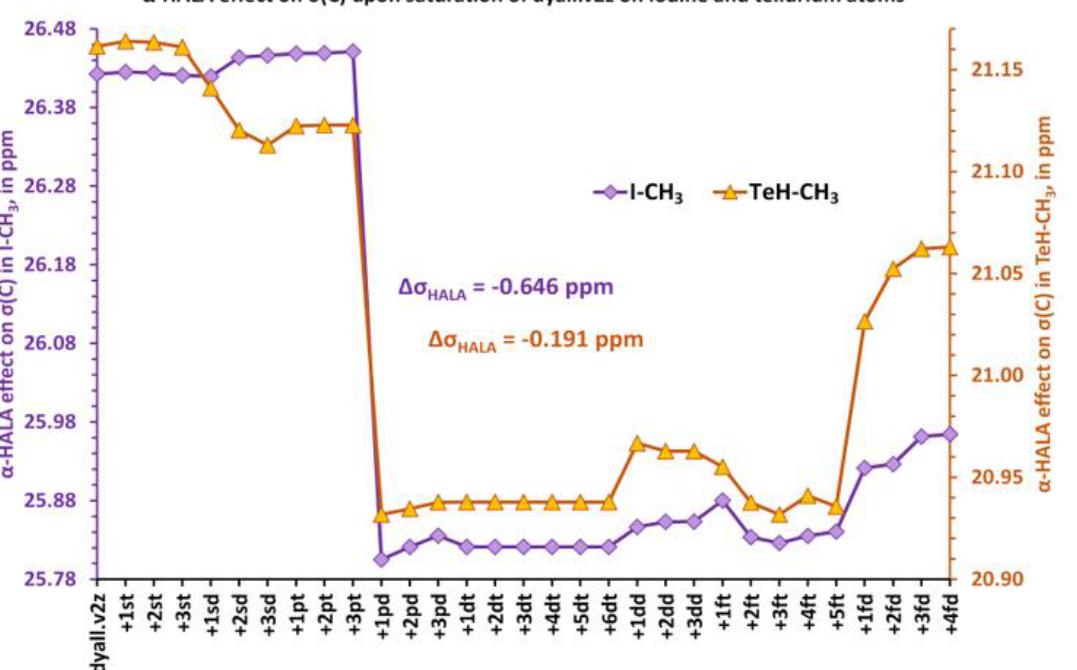
Figure 2. The change of the α -HALA effect on the carbon shielding constants of I-CH 3 and TeH-CH 3 upon saturation of the dyall.v2z basis set is used on the iodine and tellurium atoms, respectively.